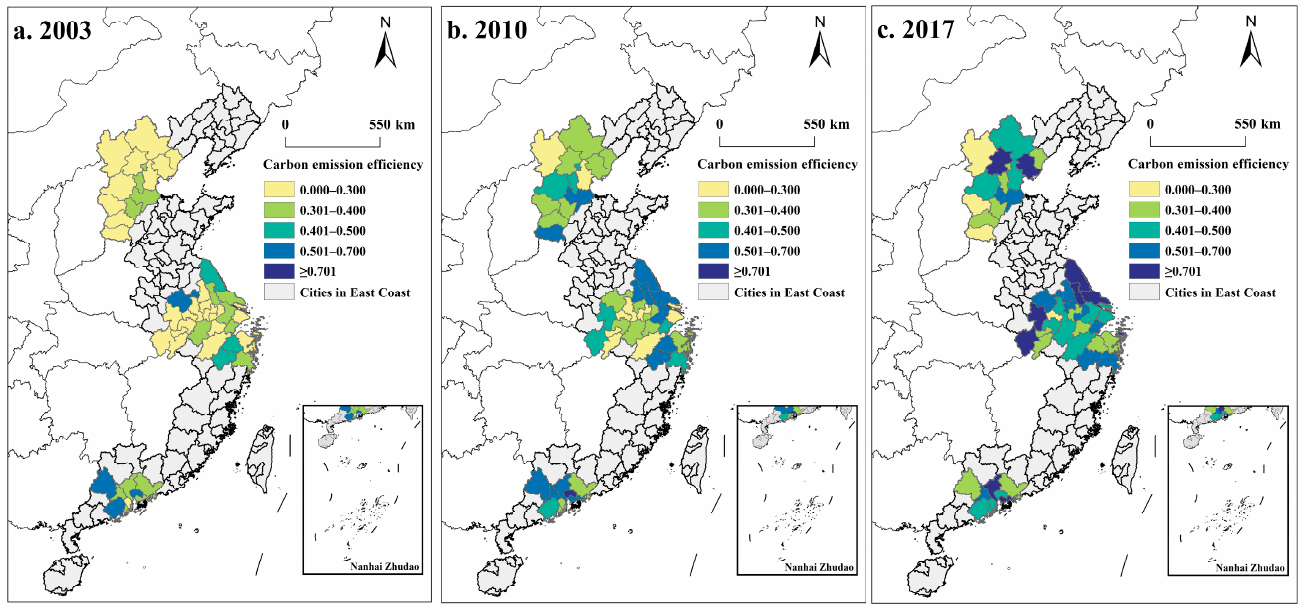
Figure 4. Spatial distribution of CEE in the three major urban agglomerations of China.